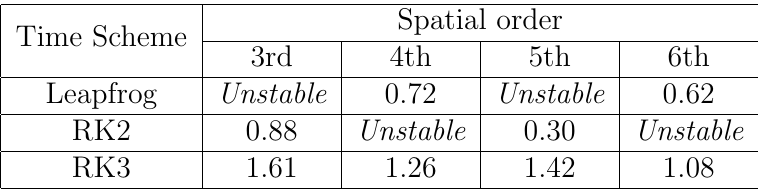
Table 3.1: Maximum stable Courant numbers for one-dimensional linear advection. From Wicker and Skamarock